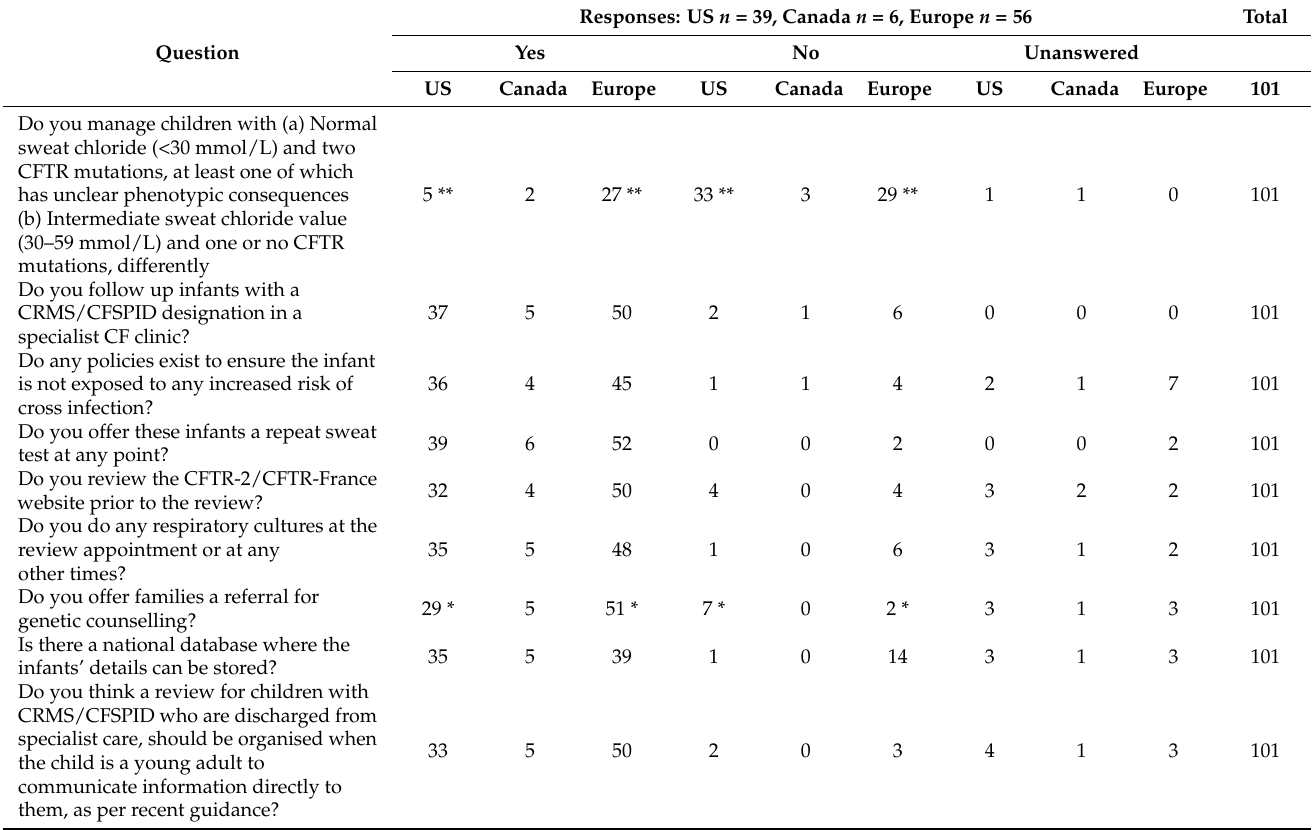
Table 3. Summary of current management for children with CRMS/CFSPID designation (* p < 0.05, ** p <